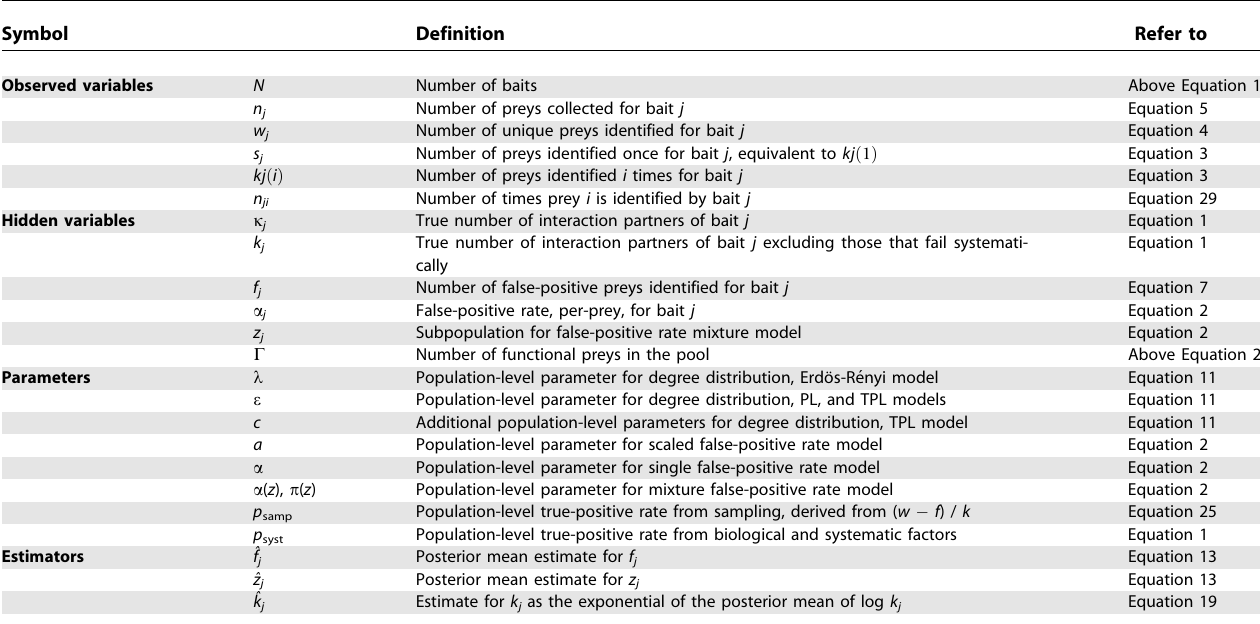
Table 1. Definitions of Symbols